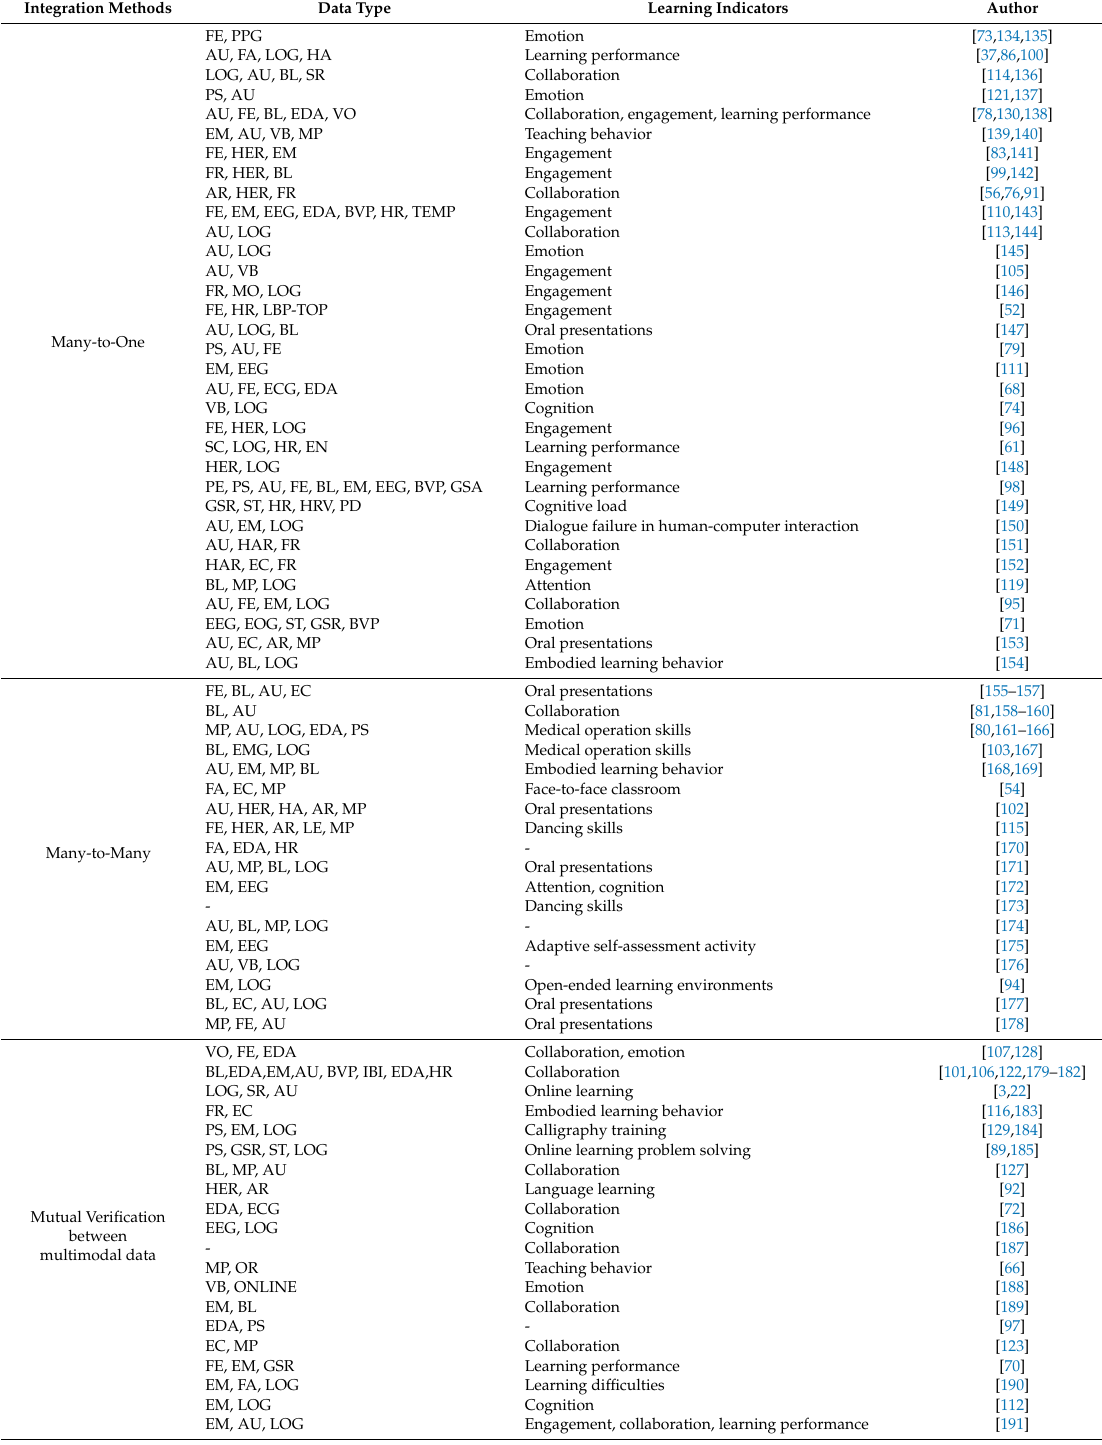
Table 6. Data integration in multimodal learning analytics